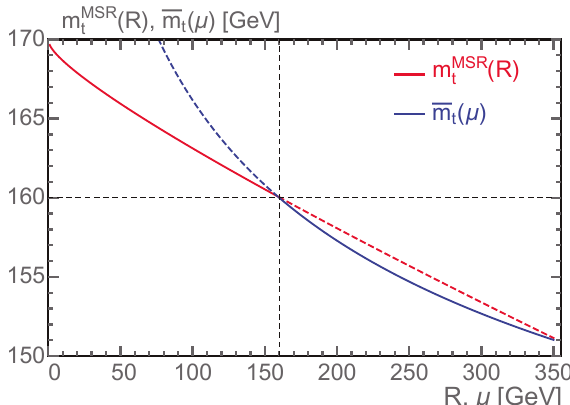
Figure 5. Comparison of the scale dependence for the MS and the MSR top quark masses ( n ‘ = 5) as a function of (cid:22) and R in